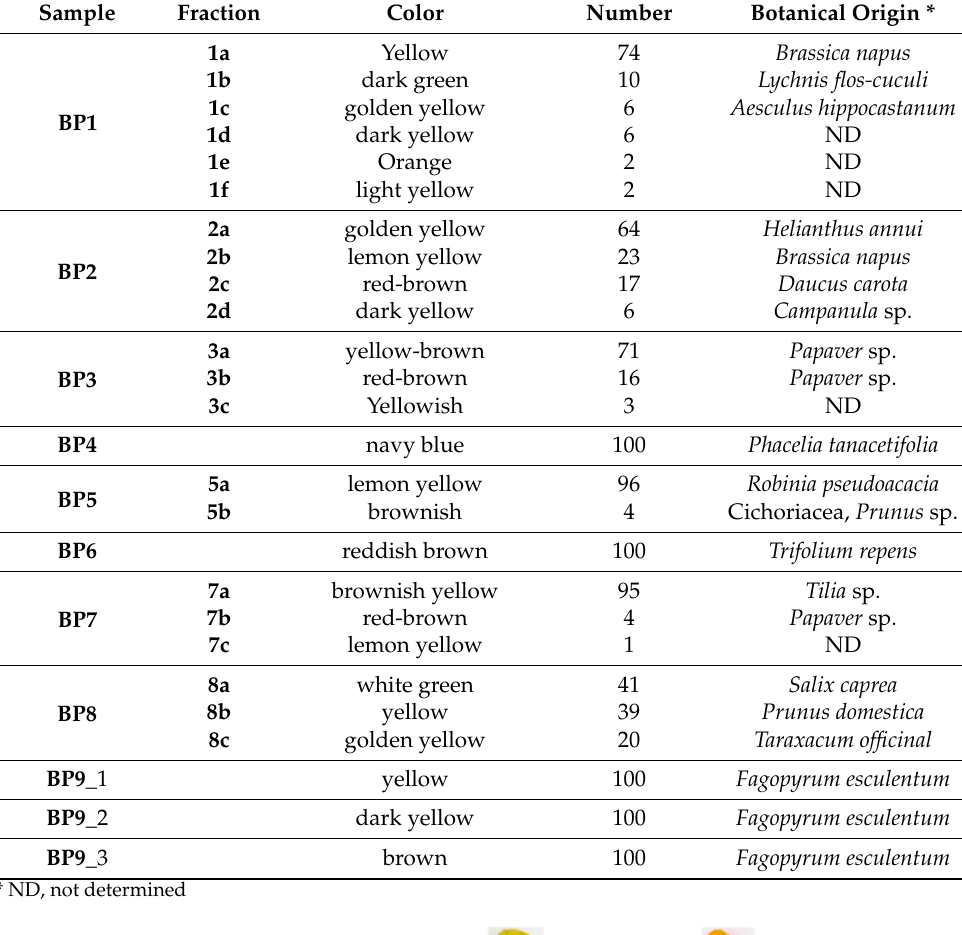
Table 2. Fractionation of bee pollen.